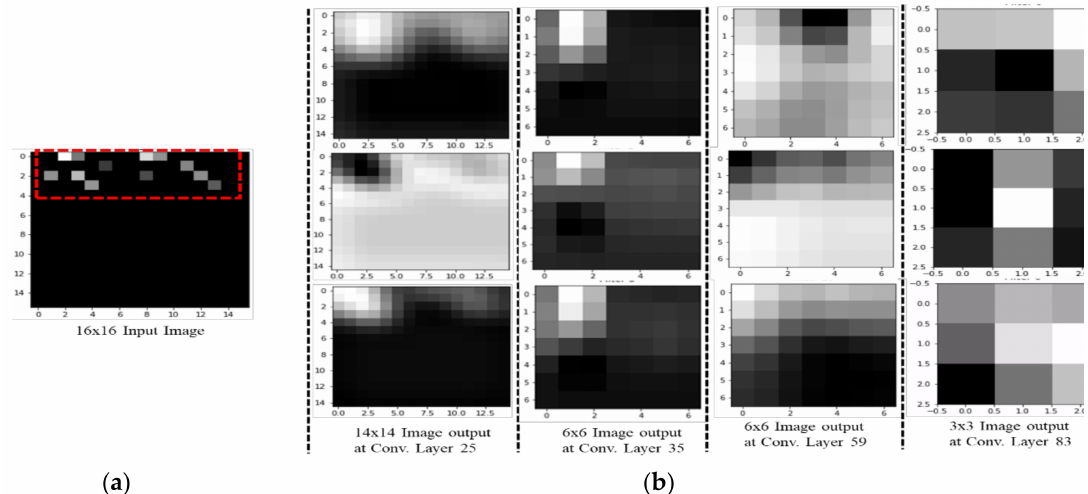
Figure 12. Images for Inception v3. ( a ) Input image. ( b ) Output image with di ff erent convolutional